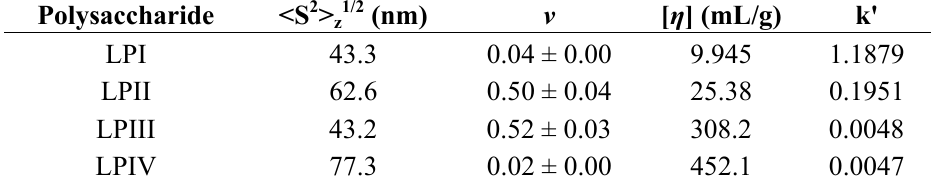
Table 1. Parameters of <S 2 > z1/2 = k M fractions